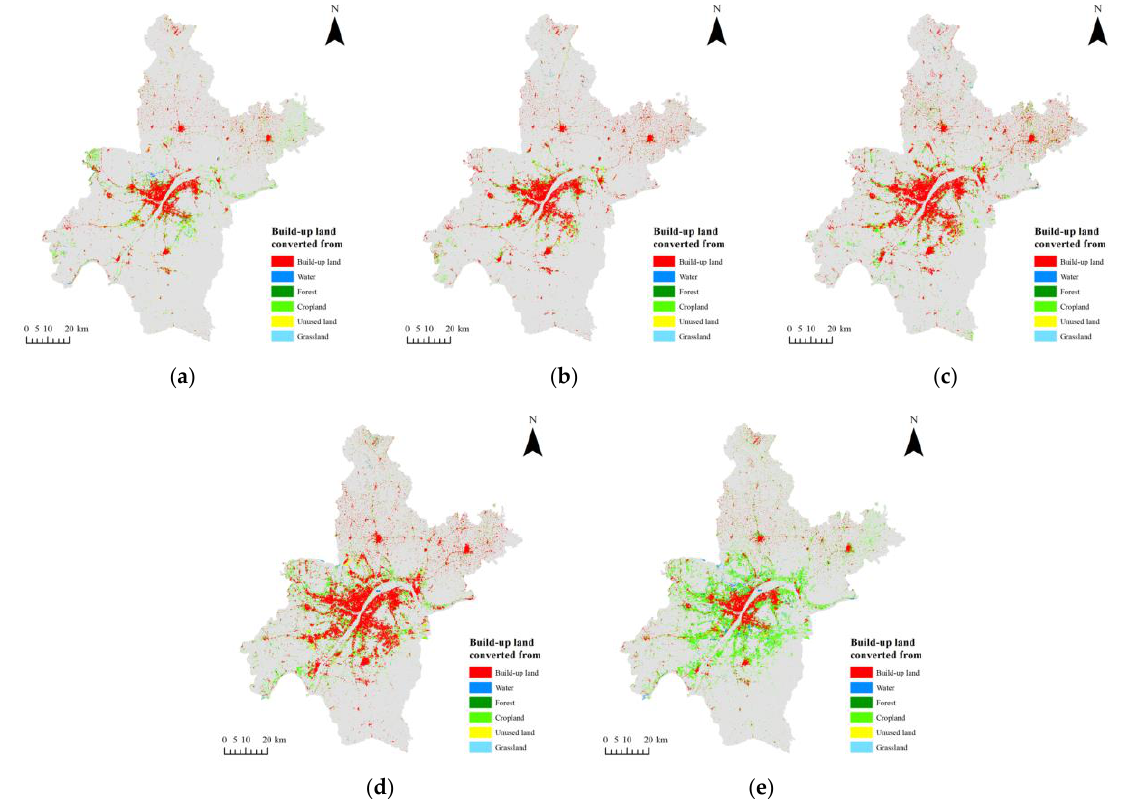
2009, 2014 and 2019.